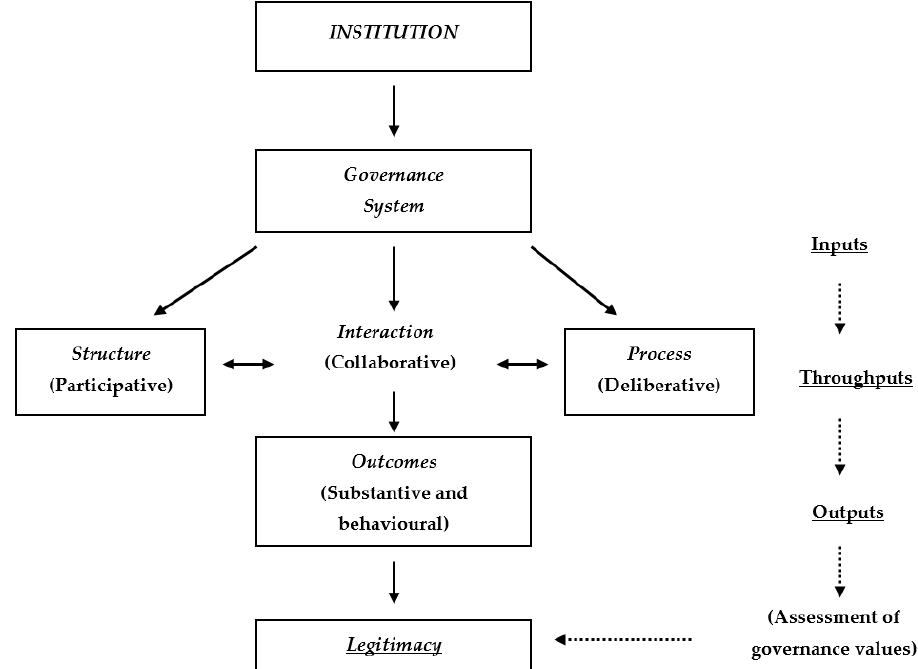
Figure 1. Theoretical model for the evaluation of contemporary global governance [39] (p. 5, adapted; courtesy of Palgrave Macmillan). Table 1. Hierarchical framework of governance values.